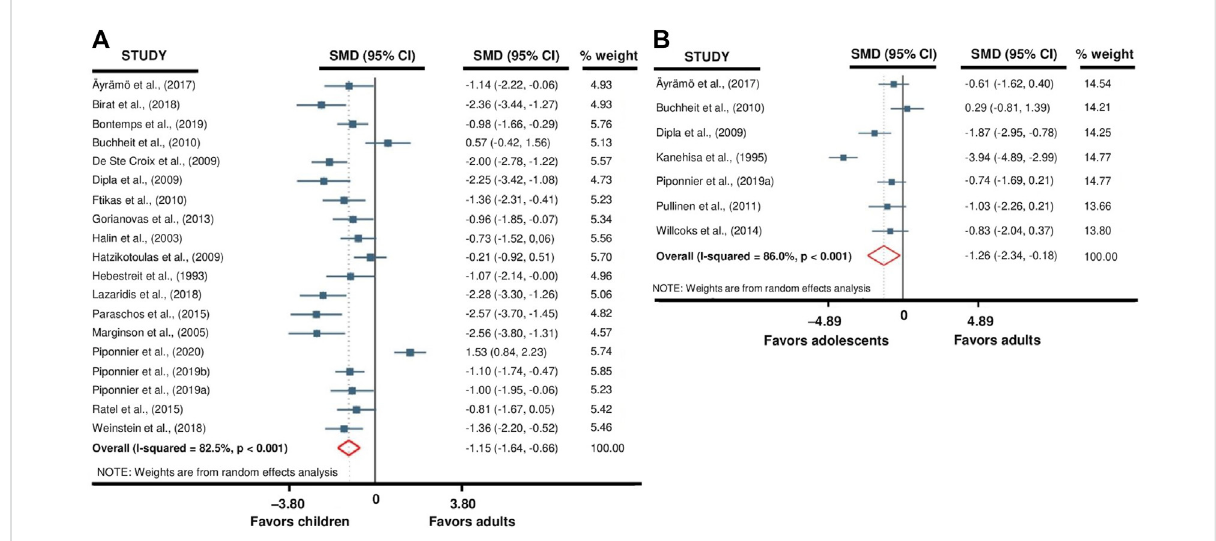
FIGURE 4 Forest plot from the meta-analysis reporting differences in fatigability between children versus adults (A) and adolescents versus adults (B)